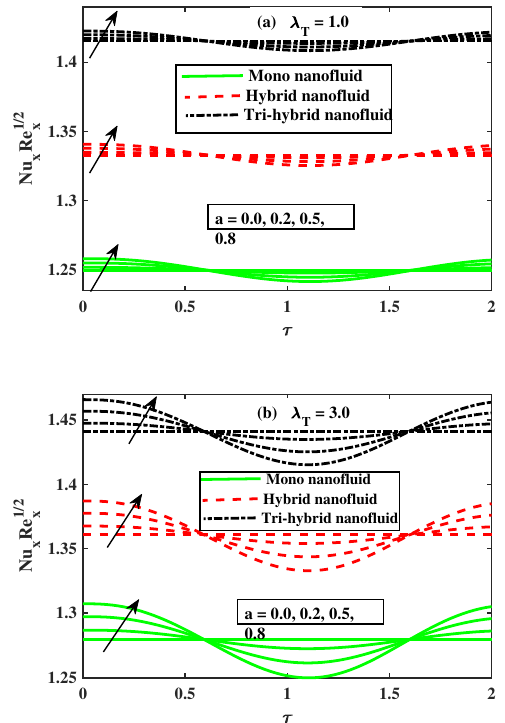
Figure 10. ( a ) Fluctuation of λ T on Nu x Re 1/2 x ; ( b ) Fluctuation of λ T on Nu x Re 1/2 x